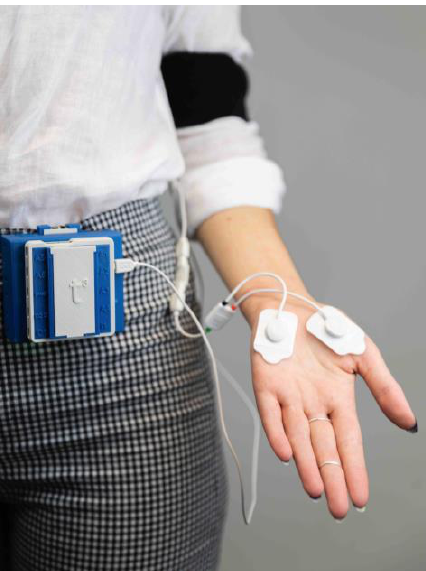
Figure 4. The electrodermal activity (EDA) device. The electrodes on the hand are connected to sensor cables which are connected to the portable EDA device. A black armband is on the arm to secure the sensor cable.